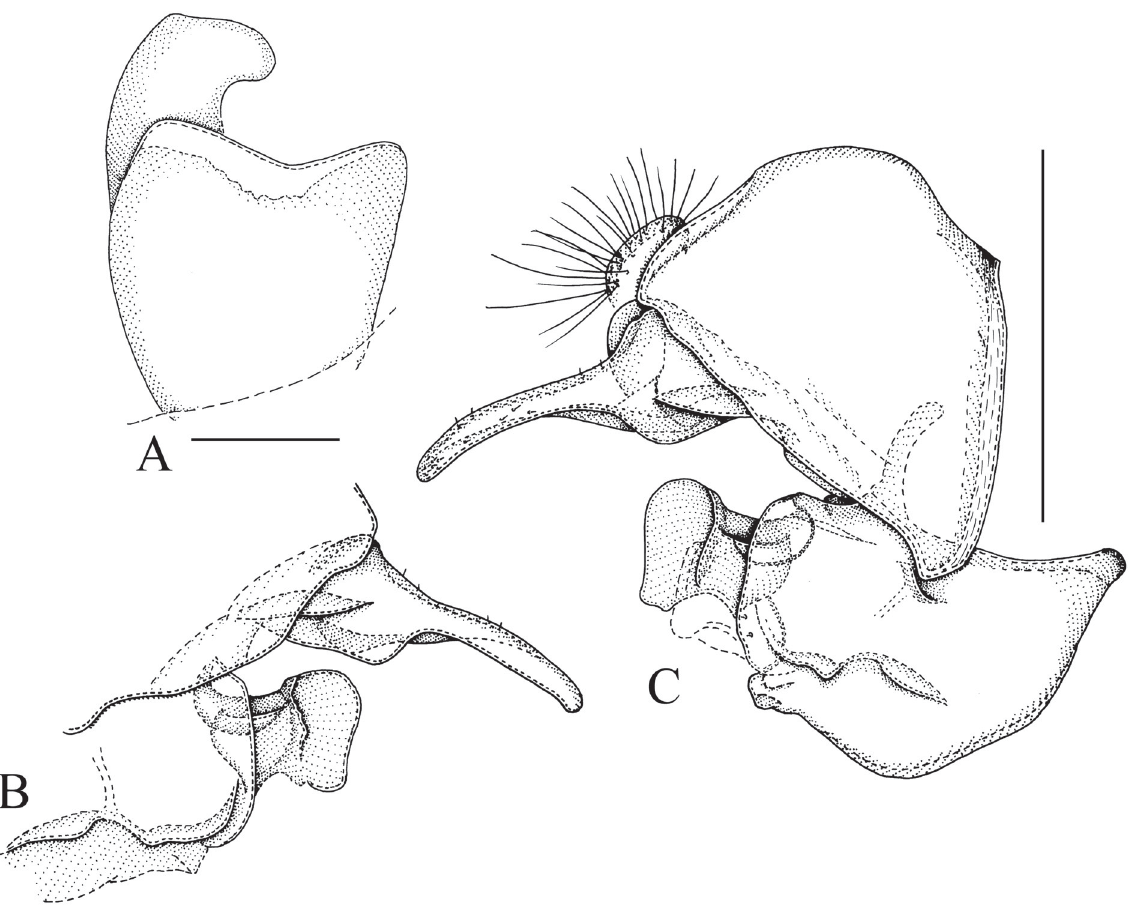
Fig. 94. Sphegina (Asiosphegina) varidissima Shiraki, 1930, ♂ Fuhsing, Taiwan. A . Sterna IV and VI, ventral view. B . Left surstylus and superior lobe wit h associated parts, lateral view. C . Genitalia, right side, lateral view. Scale bars = 0.5